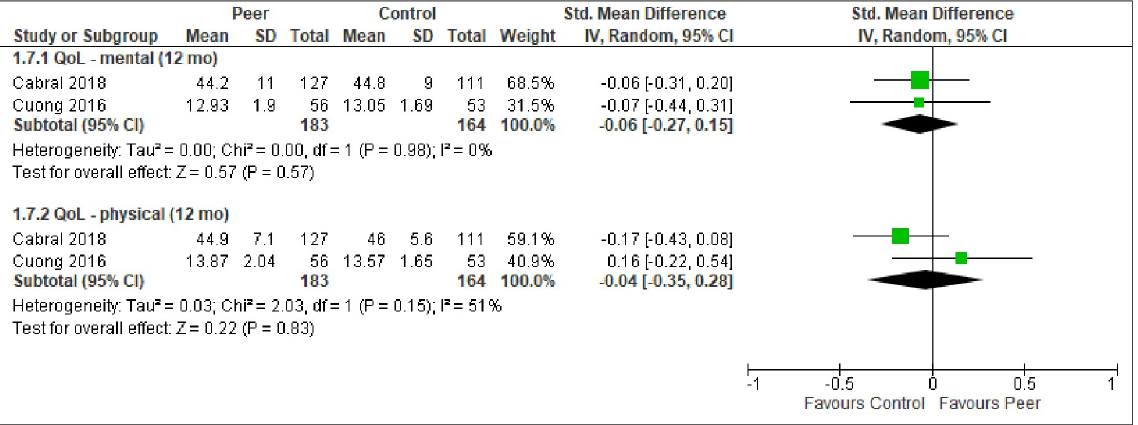
PLOS ONE | https://doi.org/10.1371/journal.pone.0252623 June 17,